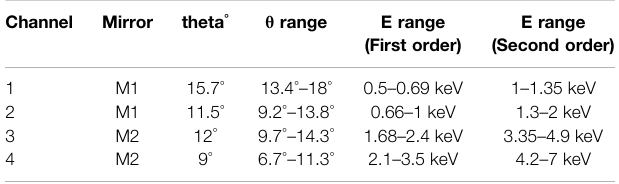
TABLE 1 | Speci fi cations of multi-layer mirrors and the positioning angles for all channels